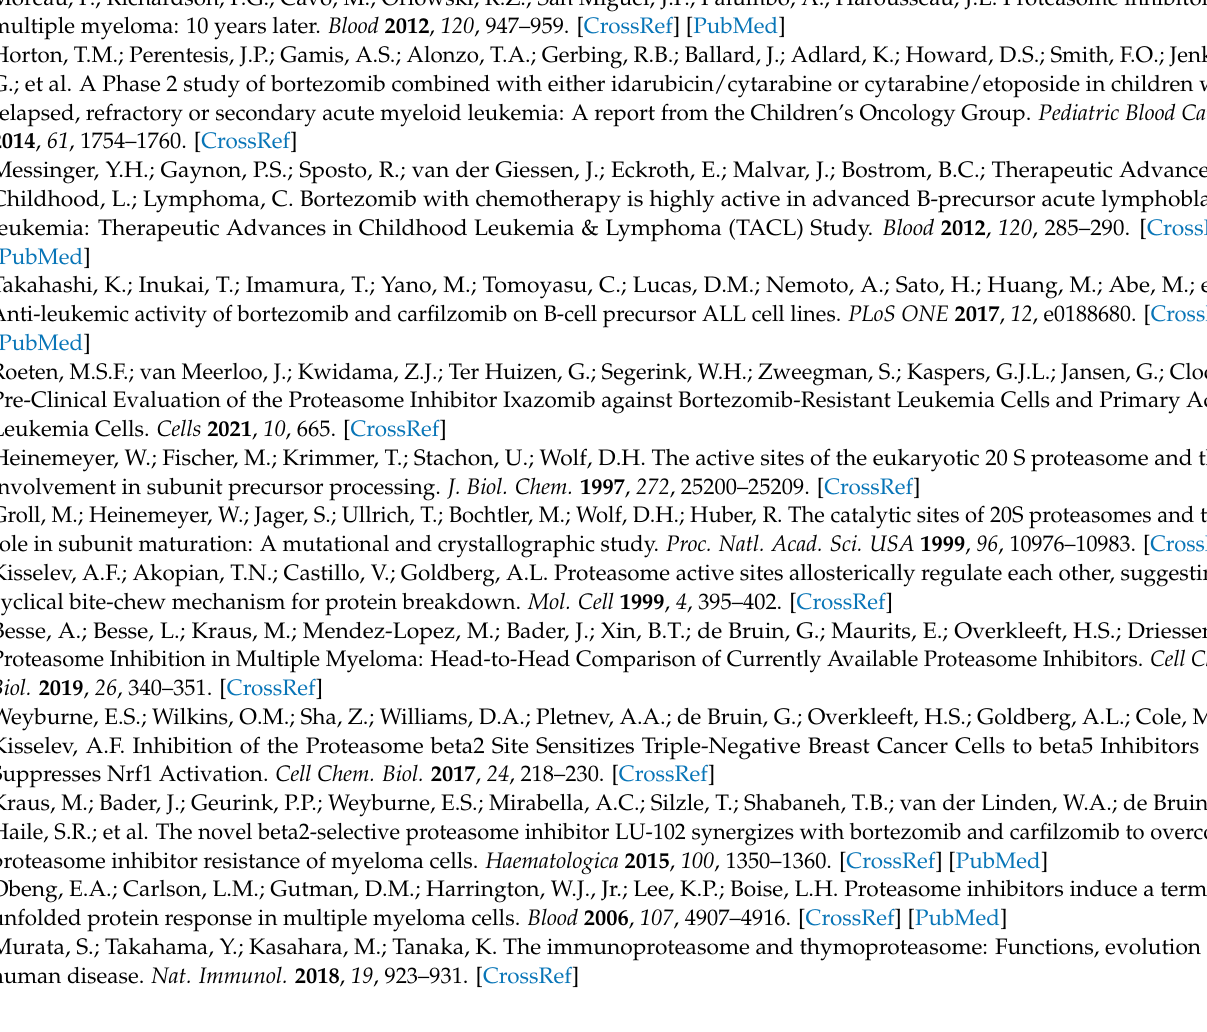
Table S2: Activity of immunoproteasome versus constitutive proteasome subunits (i/c) in BCP-ALL and